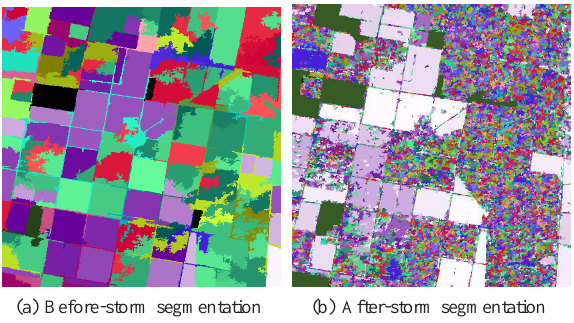
Figure 5: Segmentation of before and after-storm images using the best features, i.e red band and red band ratio respectively.